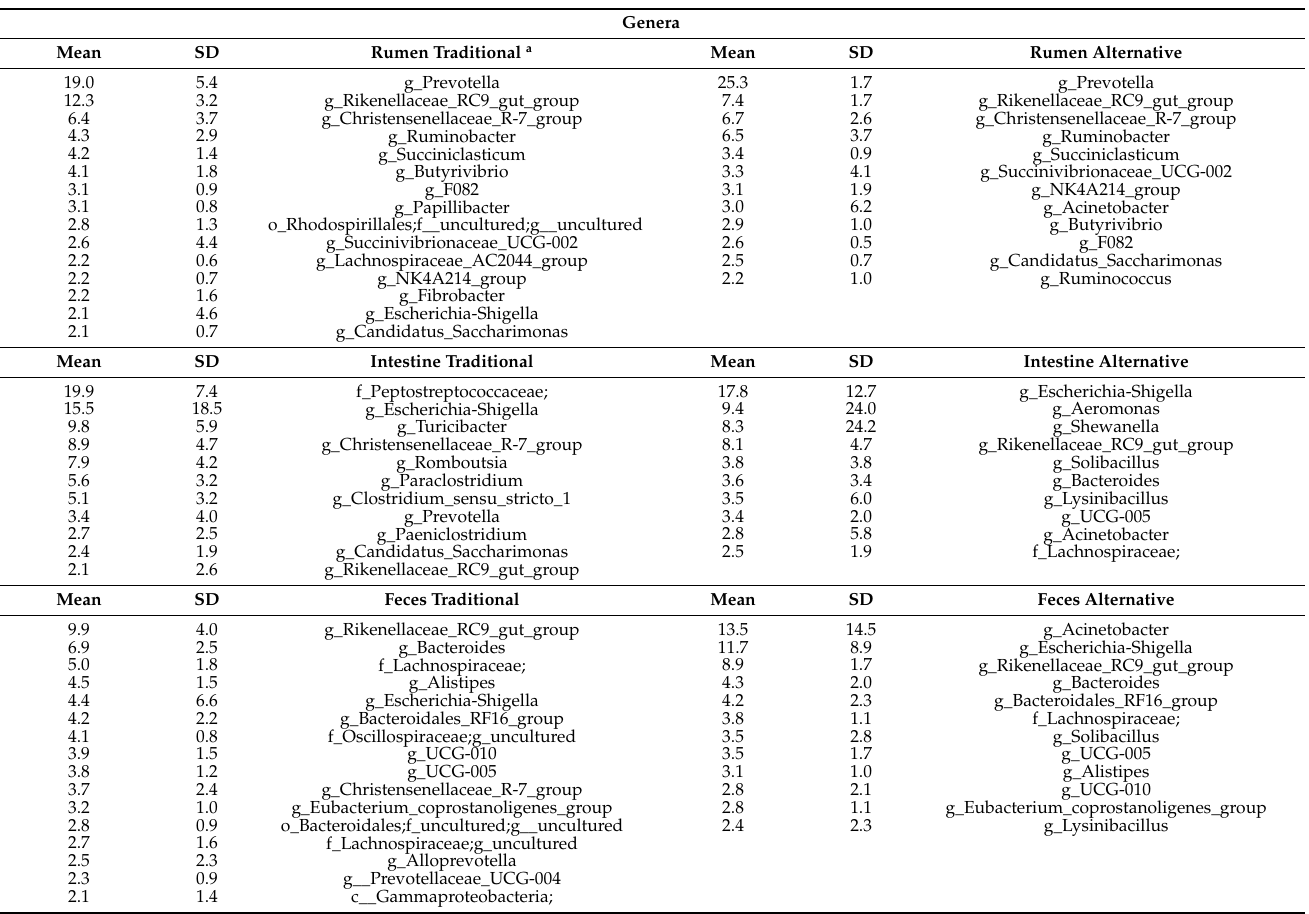
Table 2. Most abundant Families and Genera found in the analyzed gastrointestinal sites. Relative abundance (mean frequency ± SD) of the most abundant Families and Genera observed in the analyzed GIT